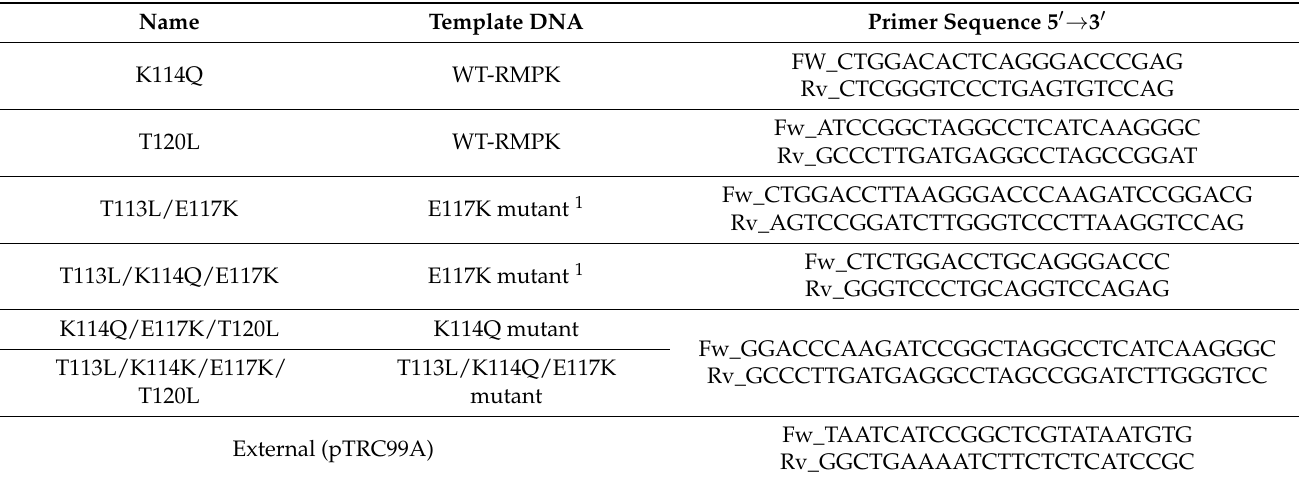
Table 3. List of DNA templates and primer sequences used in